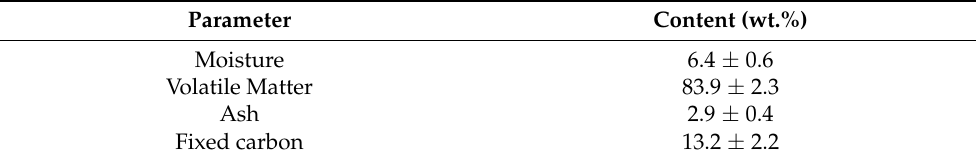
Table 1. Physical properties of G. angustifolia residues.